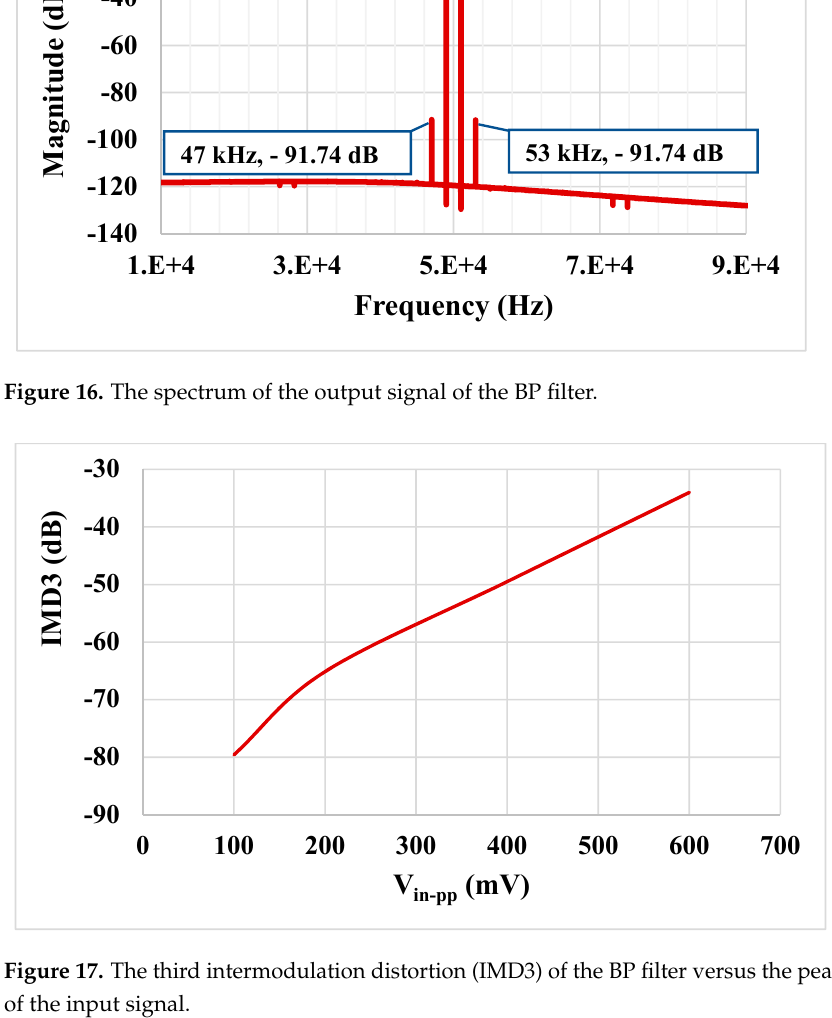
Figure 17. The third intermodulation distortion (IMD3) of the BP filter versus the peak-to-peak value of the input signal.